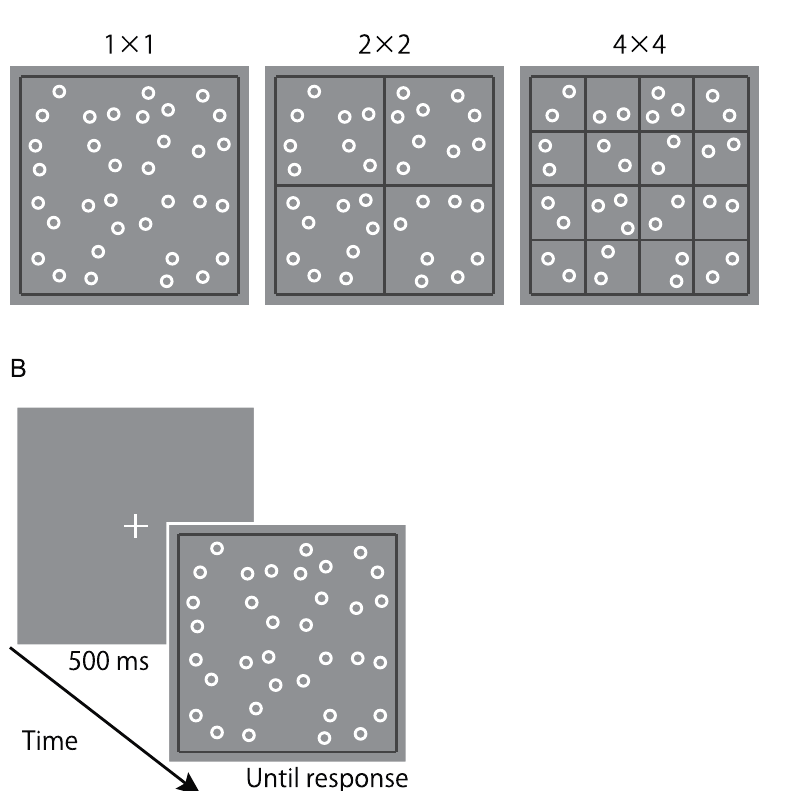
Figure 1. ( A ) Example displays for the three divider conditions. ( B ) The sequence of trial events in Experiment